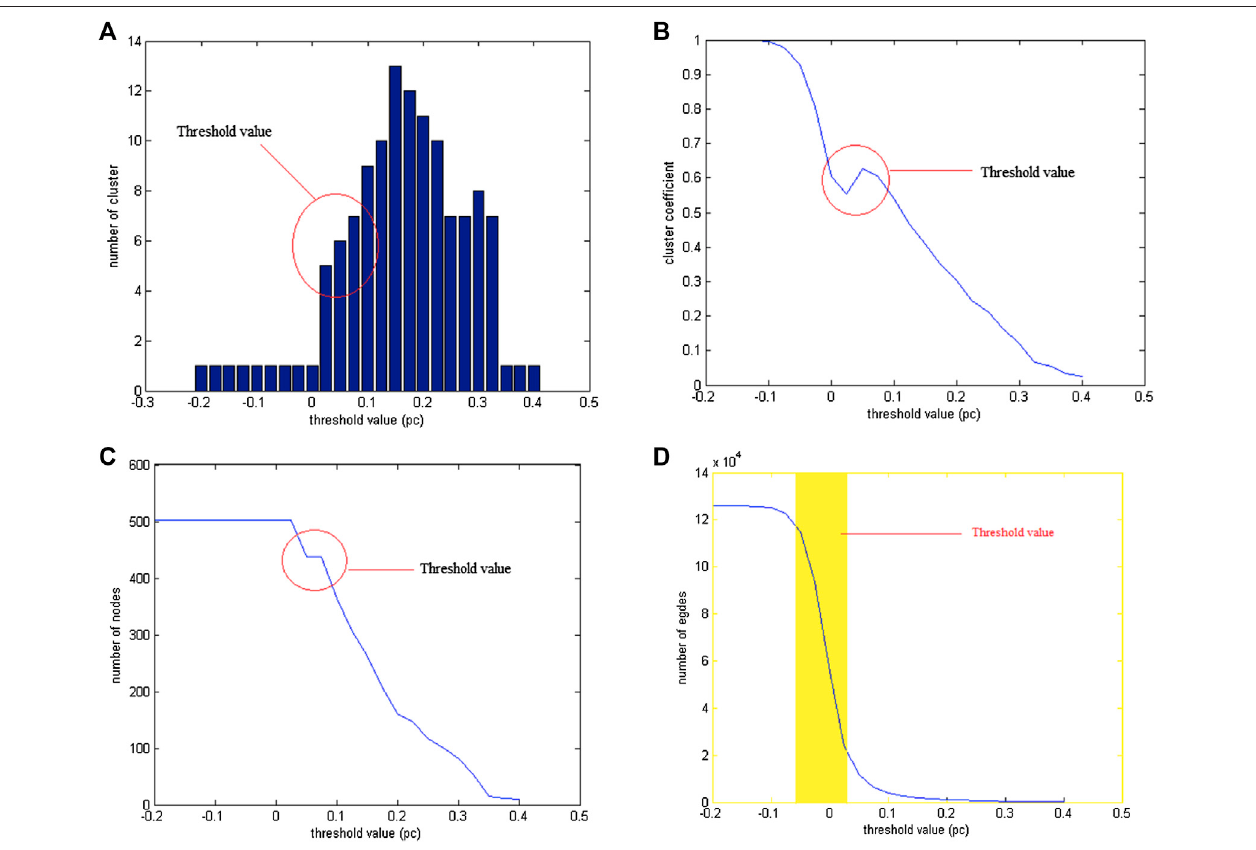
FIGURE10| Thevalue (A) numberofclustersformed, (B) numberofvertices, (C) clustercoef fi cientsand (D) numberofsideswhenboundaryvaluesvaryfrom − 0 . 2 to 0.4. The method successfully shows the threshold value. This value is important for analyzing the group effectively.